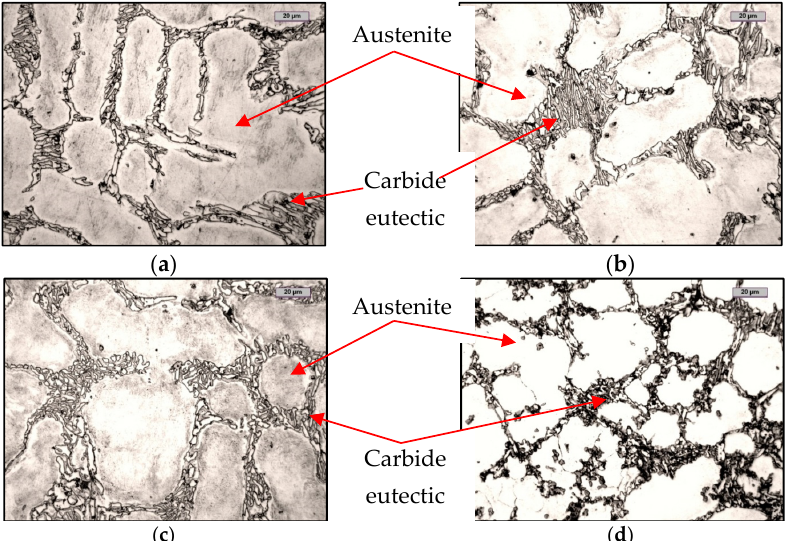
Figure 8. Microstructures of chromium cast iron samples: ( a ) reference; ( b ) inoculation of: 0.17% FeTi; ( c ) 0.33% FeTi; ( d ) 0.66% FeTi (magnification—500×).